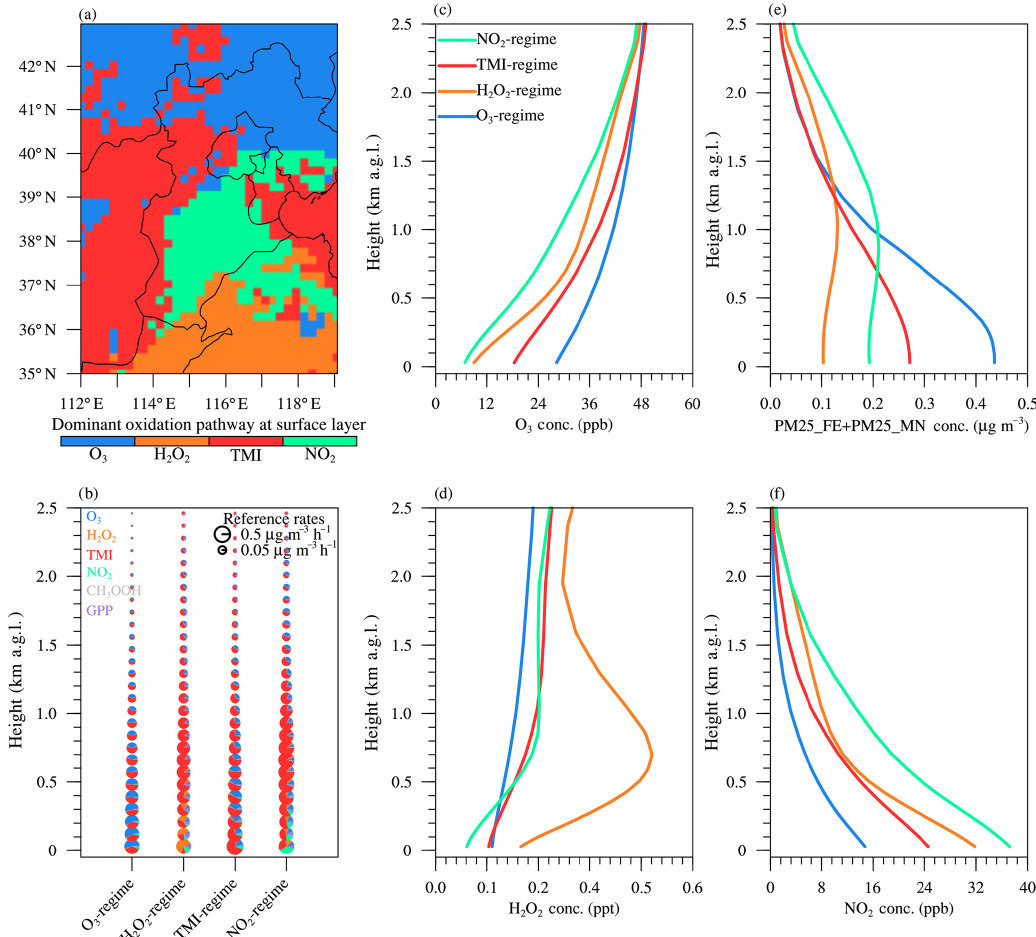
Figure 8. Dominant sulfate formation pathway at the surface layer (a) and the vertical profile of sulfate production through different path- ways (b) , as well as concentrations of the oxidants of O 3 (c) , H 2 O 2 (d) , TMI (e) , and NO 2 (f) averaged over the four dominant oxidation regimes (O 3 , H 2 O 2 , TMI, and NO 2 , respectively, as shown in Fig. 8a) and simulated in the CTRL scenario during January 2013. Contribu- tions from different sulfate formation pathways are also shown in pie charts, and the radius R for the pie chart is scaled depending on the sulfate production rate P using R/R ref = 2exp ( log10 (P/P ref ))